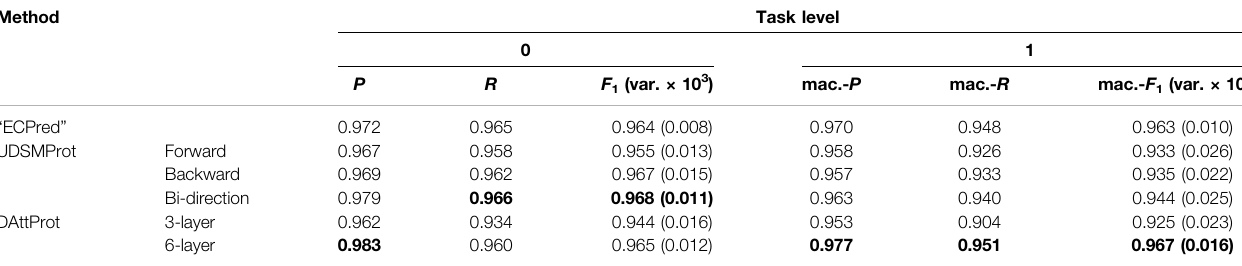
TABLE 3 | Performance results on ECPred dataset. Method